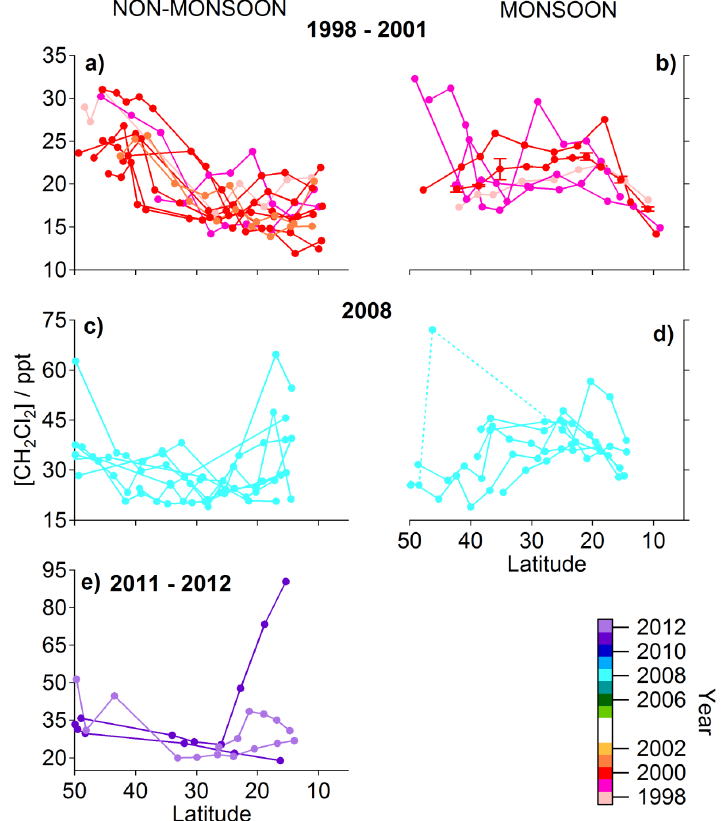
Figure 4. Latitudinal distributions of CH 2 Cl 2 observed during flights to India for non-monsoon months on the left and monsoon months (July, August, September) on the right where colour = year (see inset colour bar; colour scale is consistent with Figs. 2, 4 and 6). Where multiple measurements of the same sample have been made 1 σ error bars are given, see Sect. 2.